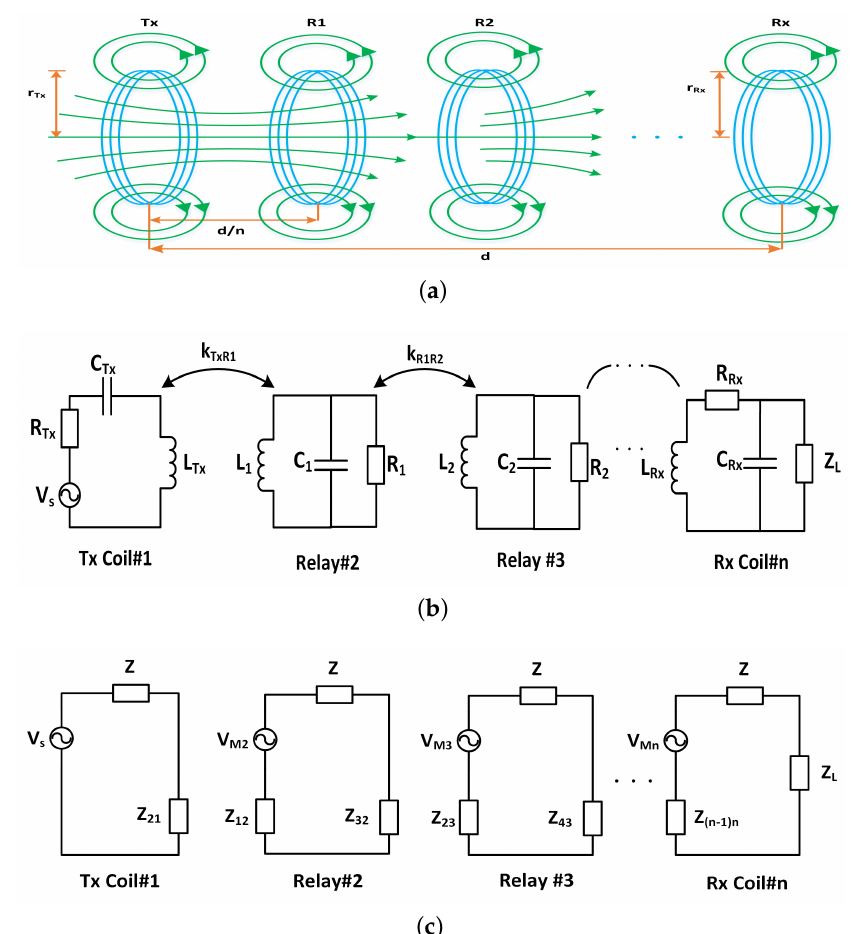
Figure 2. Magneto-inductive (MI) waveguide based communication system. ( a ) MI waveguide model, ( b ) multistage transformer model, and ( c ) equivalent circuit